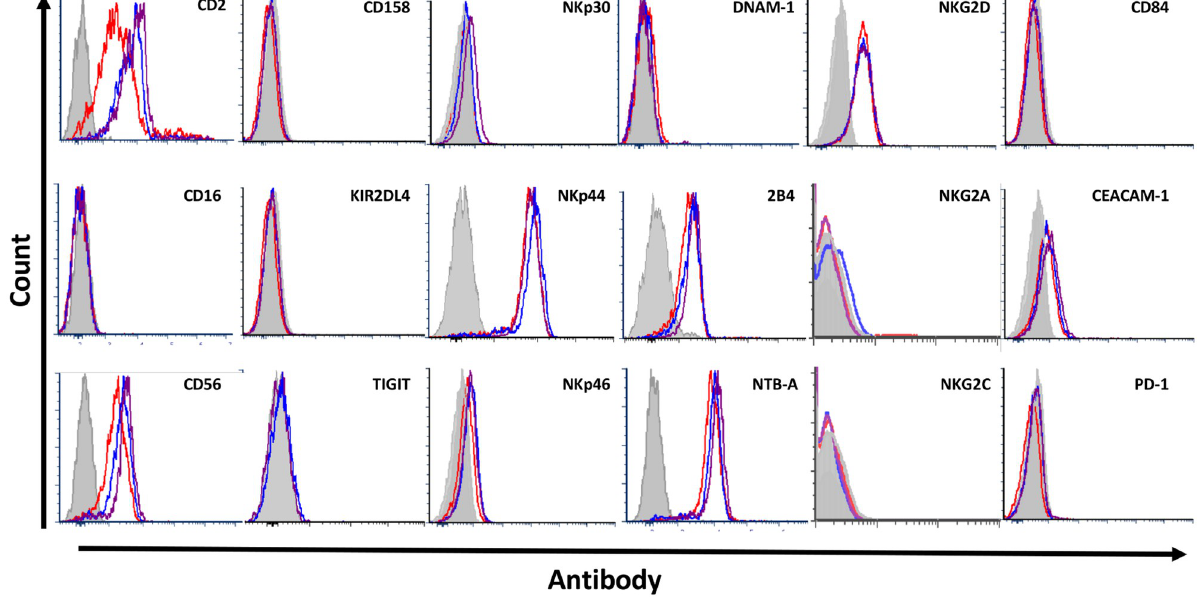
Fig 2. Characterization of surface receptor expression. 1 out of 4 representative FACS stainings against various inhibitory and activating NK cell markers (CD2, CD56), KIR (CD158, KIR2DL4), activating receptors (NKp30, NKp44, NKp46, NKG2D, NKG2C, DNAM-1, 2B4, NTB-A, CD84), and inhibitory receptors (TIGIT, CEACAM-1, PD-1, NKG2A) grey = background staining, red = NK-92med ., blue = RPMIf , violet = RPMIp .